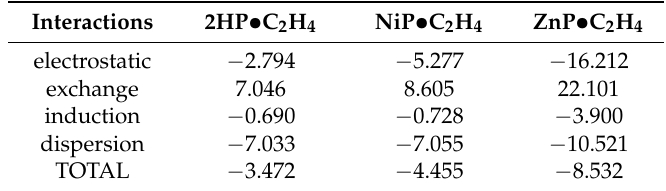
Table 5. Energy decomposition (in kcal/mol) calculated at the SAPT0/def2-TZVP level for closed-shell porphyrin–ethylene systems with M = 2H, Ni, Zn [92].